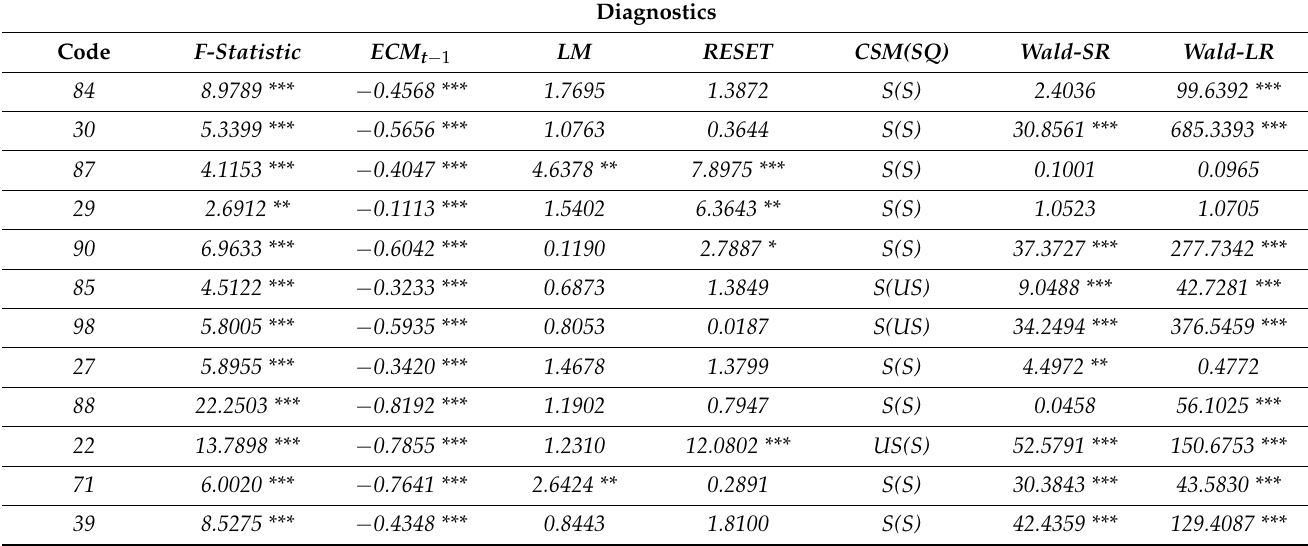
Table 12. Diagnostics in the nonlinear ARDL import demand model